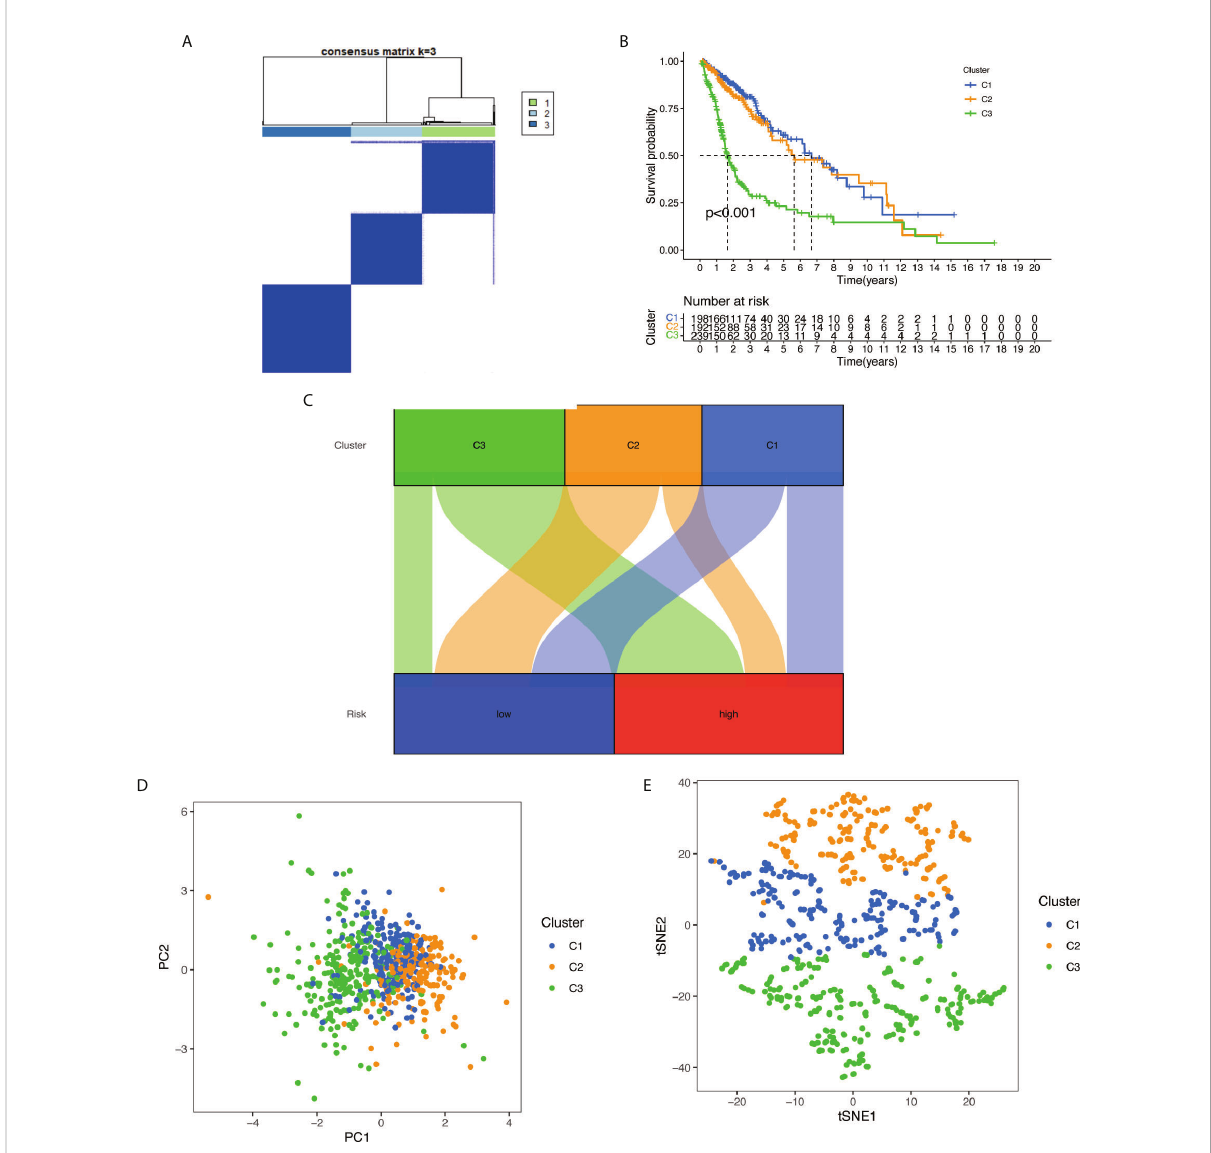
FIGURE 12 Based on the expression level of necroptosis-related lncRNA, the samples were grouped into subtypes, and survival analysis was conducted: (A) glioma patients were divided into three clusters in TCGA. (B) Overall survival curve of three clusters in TCGA. (C) A Sankey diagram for typing to check the corresponding relationship between typing and risk groups. (D) PCA indicated that three subclasses were obtained in TCGA. (E) t-SNE indicated that three subclasses were obtained in TCGA. lncRNA, long non-coding RNA; TCGA, The Cancer Genome Atlas; PCA, principal component analysis; t-SNE, t-distributed stochastic neighbor